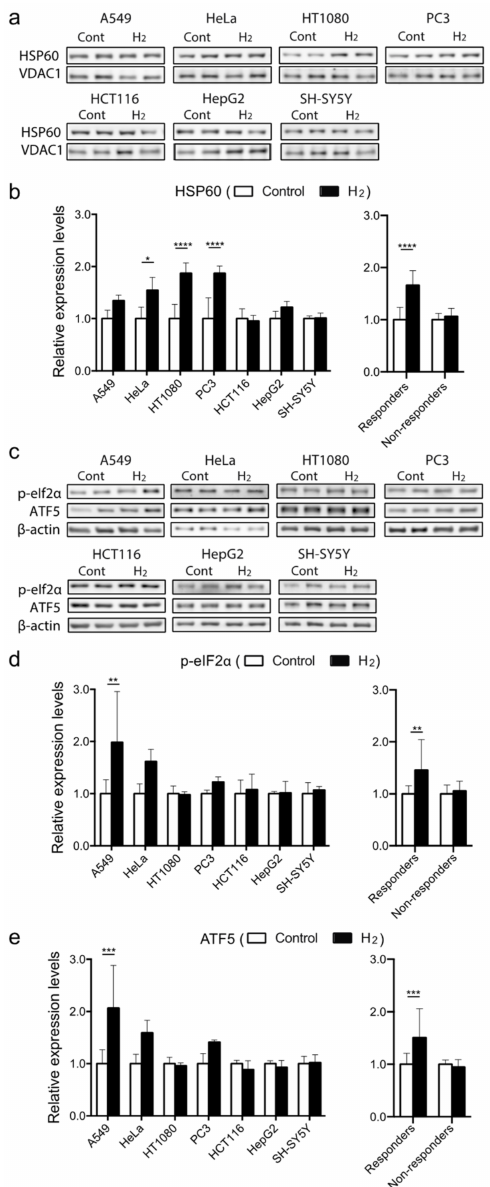
Figure 5. Expression of mtUPR-related molecules in seven cell lines under 10% hydrogen gas.